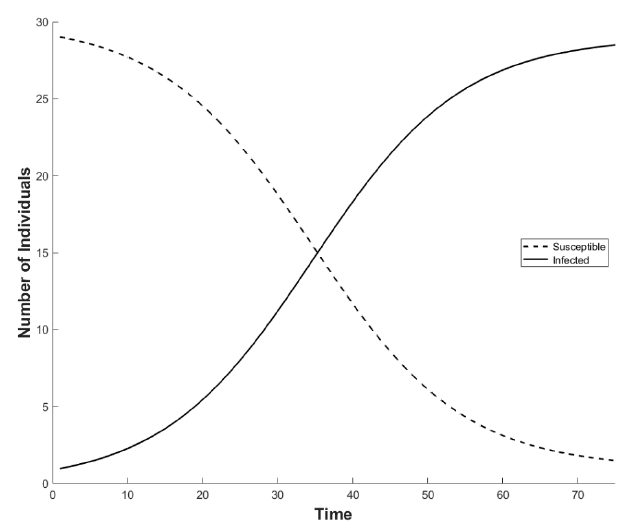
Figure 4. The average expectation of the ranavirus dynamics in a population of adult common frogs ( Rana temporaria ) through time (years). ( Ψ = 0.45; σ = 0.3; M N = 0.2; M D = 0.775; starting population comprised of A I = 1 and A S = 29.) A I is the number of infected individuals, A S is the number of susceptible individuals, Ψ is the contact rate, σ is the likelihood of transmission, M N is the natural mortality rate, and M D is the mortality rate associated with ranavirosis.